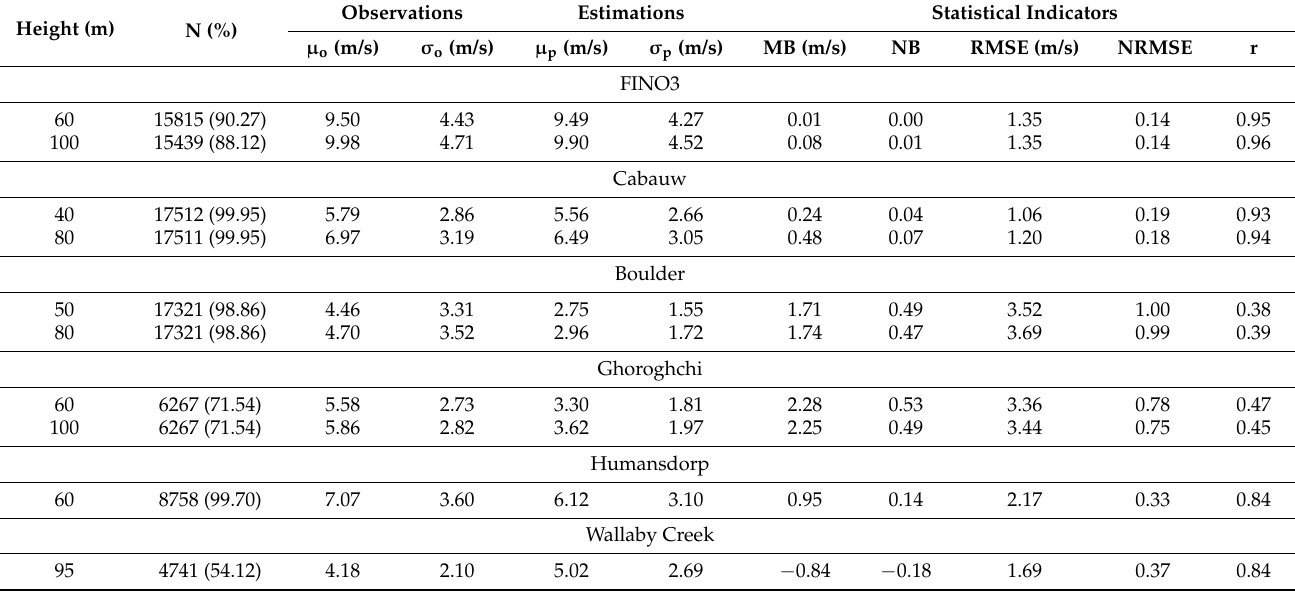
Table 4. Statistical values of annual wind speed observed vs. estimated by ERA5 at the six towers 1 . Observations Estimations Statistical Indicators Height (m) N (%)